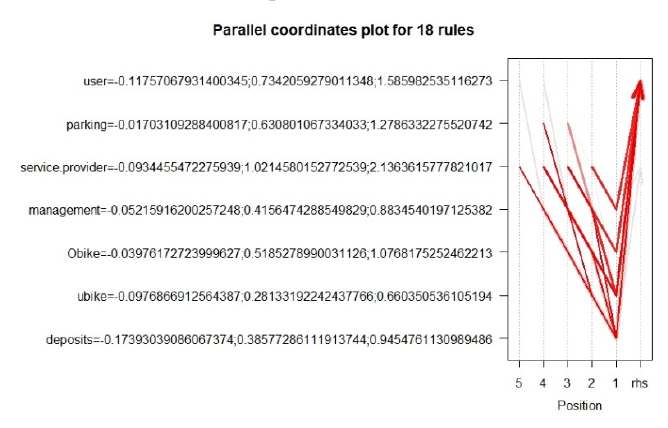
Figure 3. Boxplot of imbalance measure.